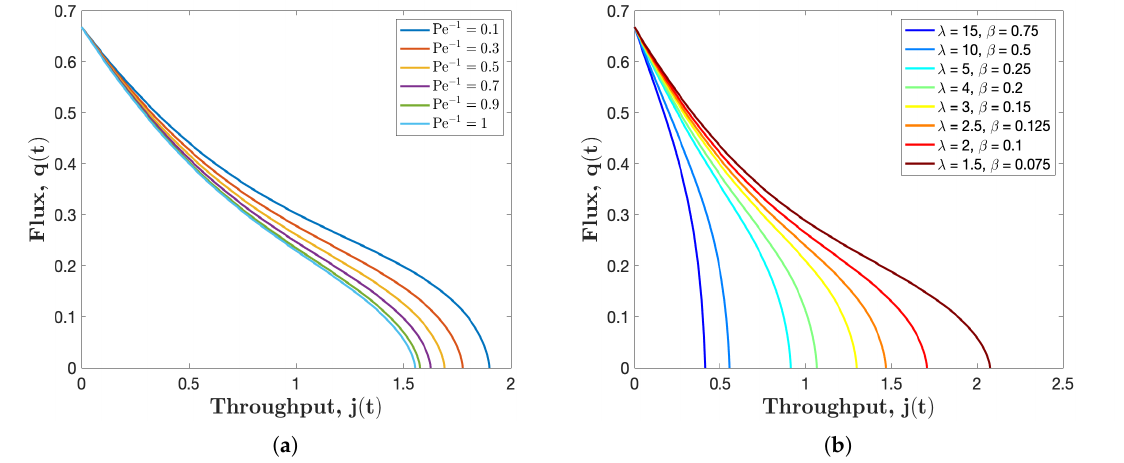
Figure 6. Flux q ( t ) versus throughput j ( t ) graphs for several different values of: ( a ) Pe − 1 , with λ = 2 and β = 0.1; and ( b ) λ and β , with λ ∝ β and Pe = 2. In both figures the initial pore profile a ( x ,0 ) = 0.9 and ρ b =